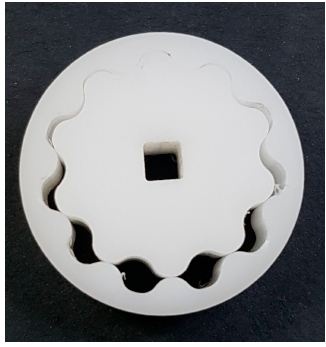
Figure 4. Mini trochoidal-gear polyoxymethylene (POM) set. Table 2. Polyoxymethylene characteristics of [31].